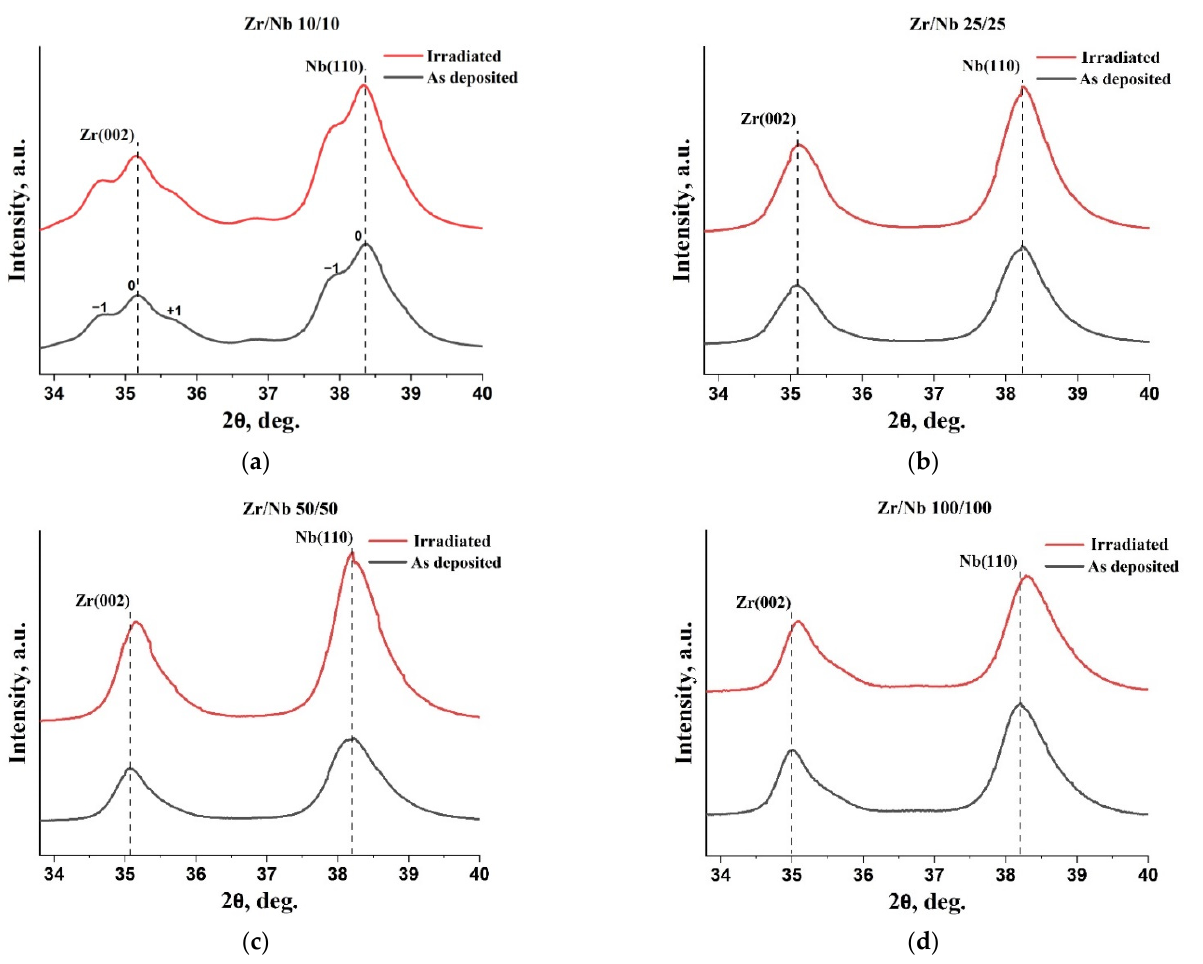
Figure 5. XRD patterns of as-deposited and irradiated Zr/Nb NMCs with individual layer thicknesses varying from 10 to 100 nm: ( a ) Zr/Nb 10/10, ( b ) Zr/Nb 25/25, ( c ) Zr/Nb 50/50, and ( d ) Zr/Nb 100/100.